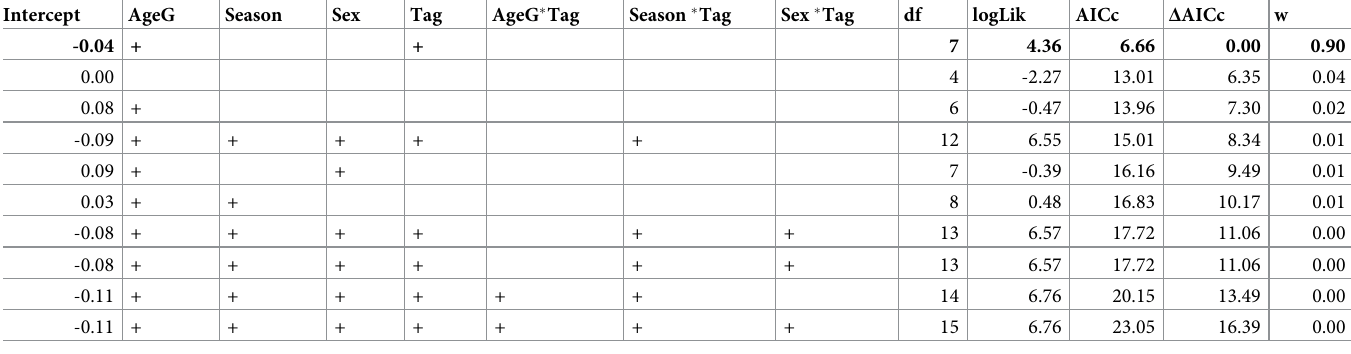
Table 2. The model selection results investigating the percentage daily body weight change between two subsequent captures of Eurasian beavers ( Castor fiber ) in southeastern Norway (2006–2020). Each model represents a linear mixed effect model with year and beaver ID included as random effects. Potential fixed effects included in each candidate model are age group of the beaver, season of tagging, sex of the beaver, and whether the beaver was tagged or not. The plus signs indicate which variables were included in each candidate model. Degrees of freedom (df), log likelihood (logLik) and model AIC weight (w) are provided for each candidate model. Results for the best supported model are shown in bold.